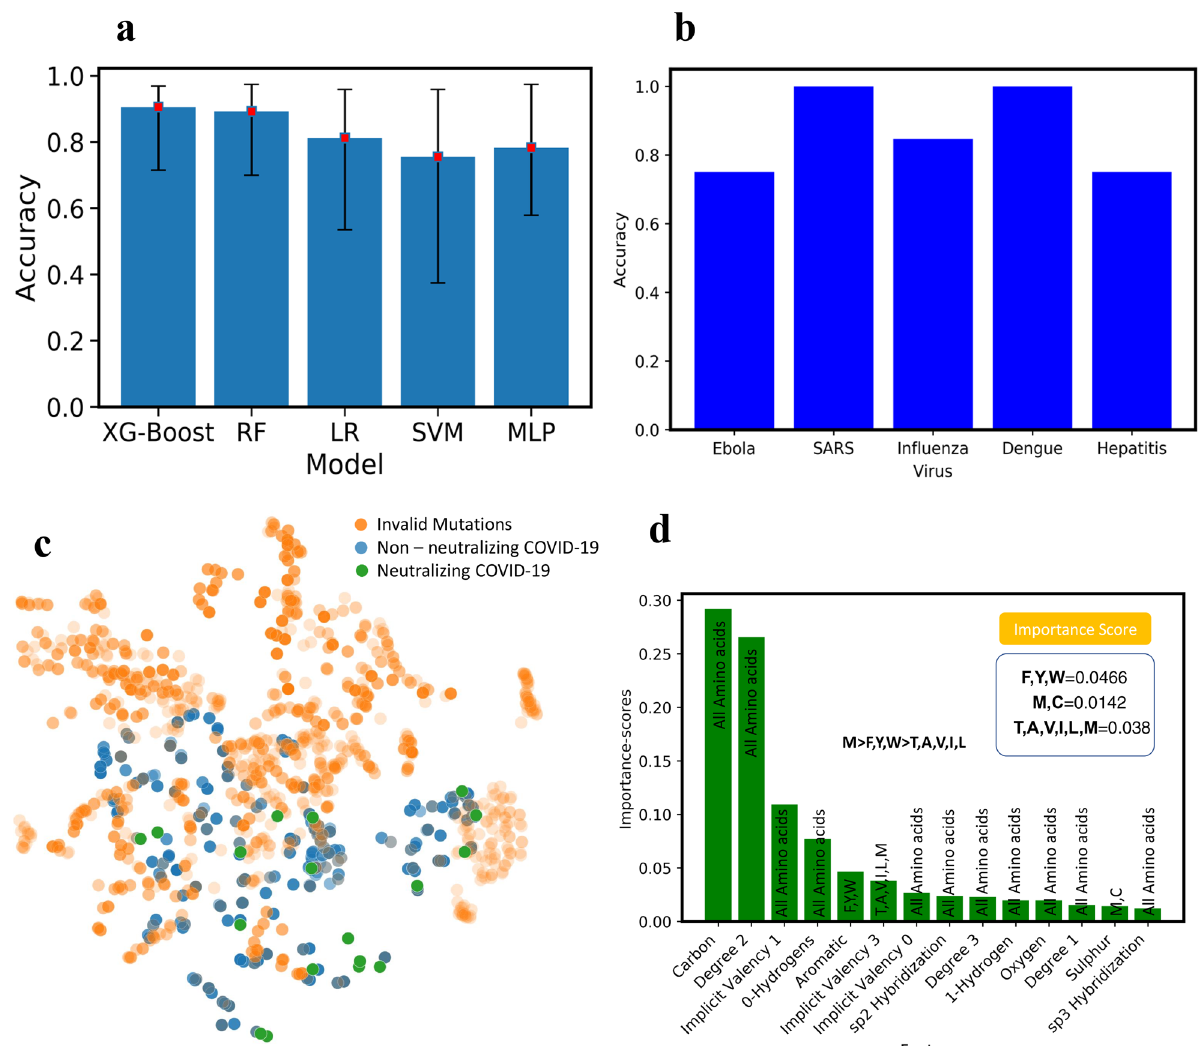
Figure 3. ( a ) The test accuracy with five-fold cross validation for XG-Boost, Random Forrest (RF), Logistic Regression (LR), Support Vector Machine (SVM) and Deep Learning (Multilayer Perceptron. XGBoost has the highest performance with (90.75%). ( b ) Out of training class test accuracy for influenza, Dengue, Ebola, Hepatitis, and SARS. To perform this test, for example for influenza, all the influenza virus-antibody